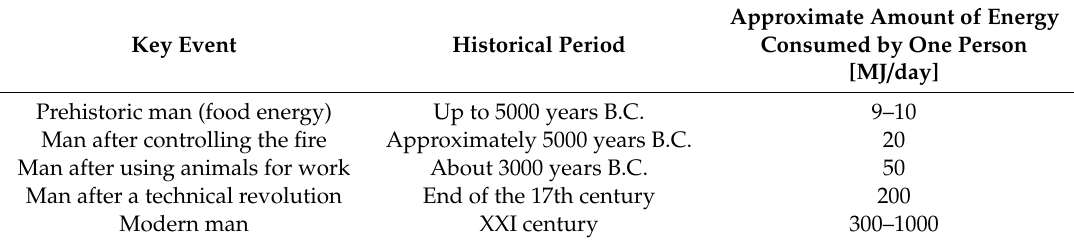
Table 1. Energy consumption over the centuries per person per day